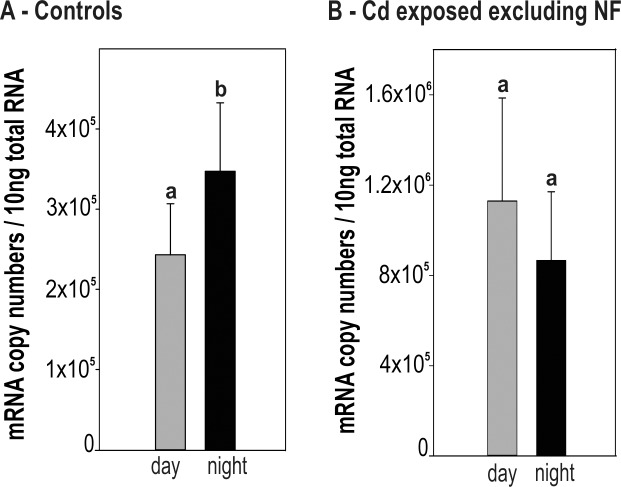
Comparison of CdMT mRNA expression between day and night in Helix pomatia.Bar graph with means and standard deviations (+SD) of CdMT mRNA copy numbers / 10ng total RNA of day and night-collected samples from control snails (n = 15 each) (A) and Cd-exposed individuals after exclusion of non-feeders (n = 12 each) (B) are shown. Significant differences between day (= grey bars) and night samples (= black bars) (t-test, P = 0.0008) are indicated by different lower case letters (a, b).